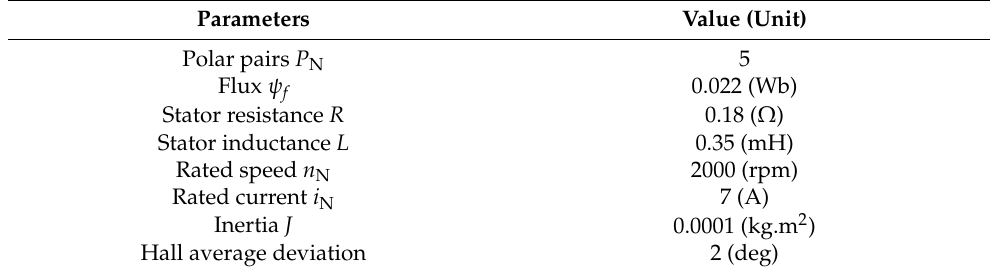
Table 1. Parameters of the